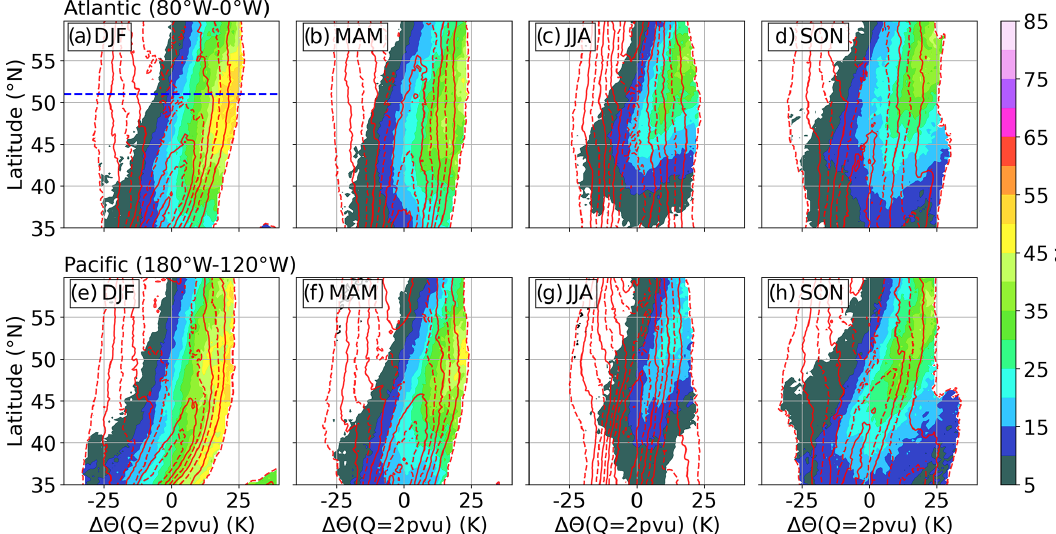
Figure 10. Occurrence frequency of (cid:49)(cid:50)(Q = 2pvu ) deviations from (cid:50)(Q = 2pvu ) as in Fig. 8c, with meridional dependency. Dashed (solid) red lines indicate occurrence frequencies isolines, beginning at 0 . 5% (1 . 0%) and in steps of 1 . 0%. Color contour shows occurrence frequency for S 2 ≥ S 2 t between 1km below and 2km above the local LRT and within the (cid:50)(Q = 2pvu ) bins. (a–d) DJF, MAM, JJA, and SON over the North Atlantic region. (e–h) Same for the Northeast Pacific region. Dashed blue line in panel (a) indicates location of Fig.